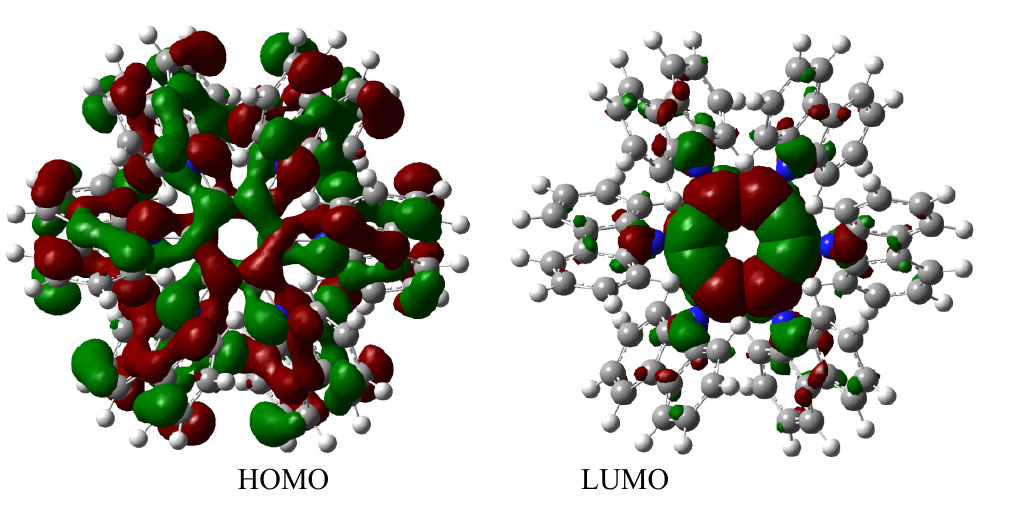
Figure 7. Frontier molecular orbitals for HAB3